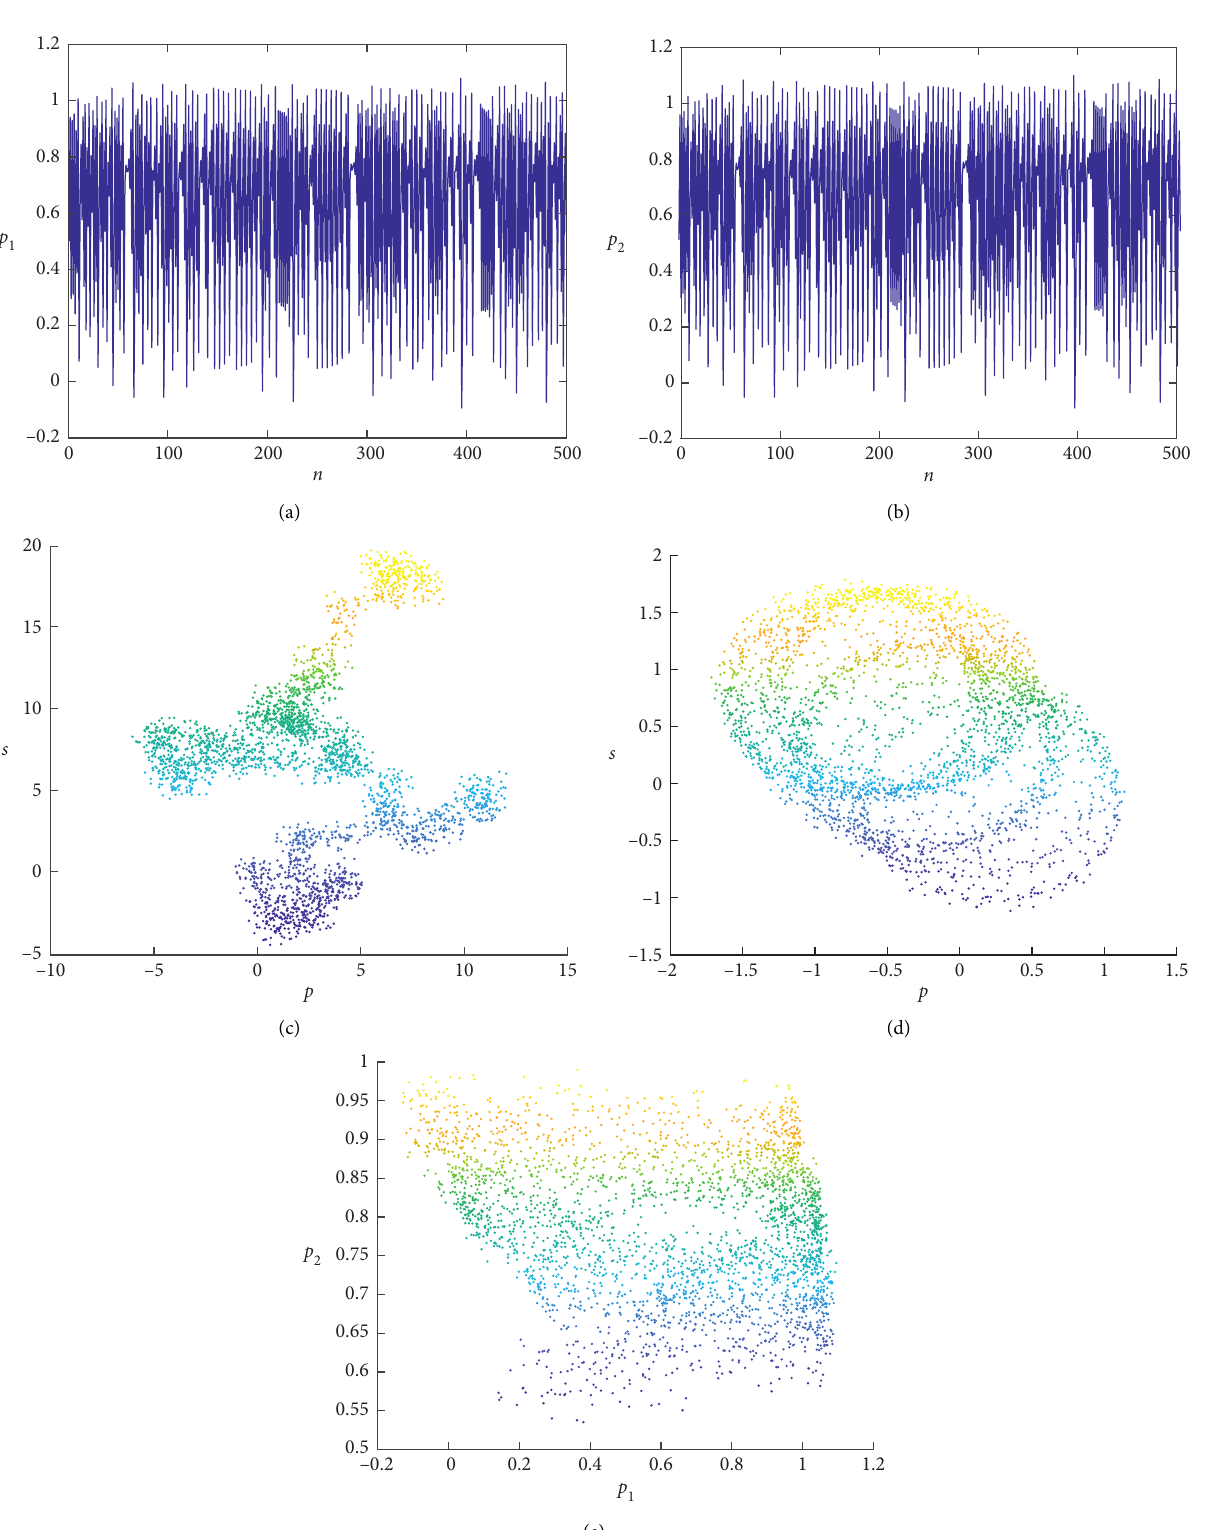
Figure 3: Chaos in system (14) with ( p ( 0 ) , p ( 0 )) � ( 0 . 3 , 0 . 3 ) . (a) Price time series of firm 1. (b) Price time series of firm 2. (c) Firm 1’s 1 2 pricing translation components ( p , s ). (d) Firm 2’s pricing translation components ( p , s ). (e) Phase portrait of duopoly